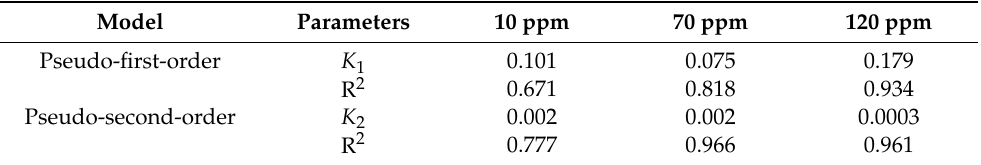
Table 7. Pseudo-first- and pseudo-second-order parameters.